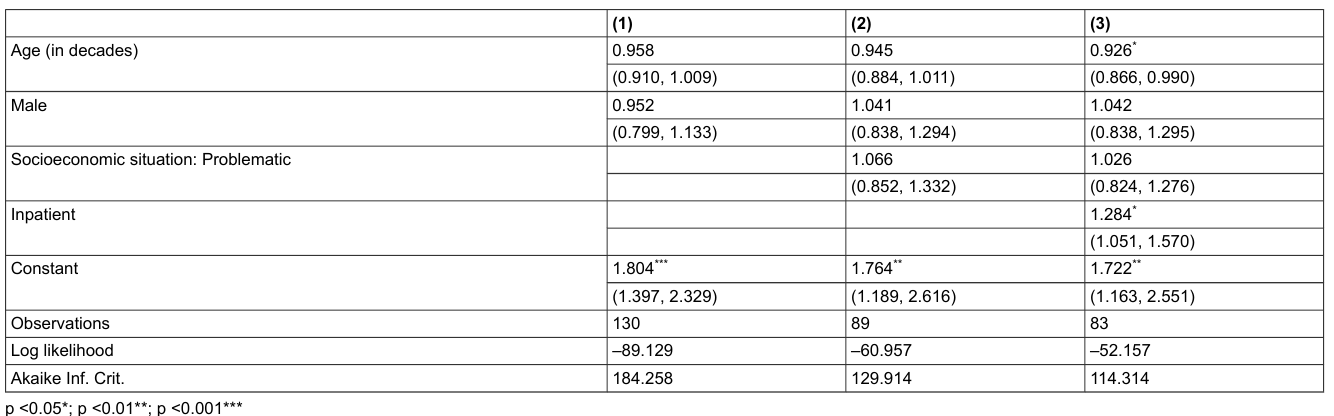
Table 9: Logistic regressions on the response: “Recent significant event = Family